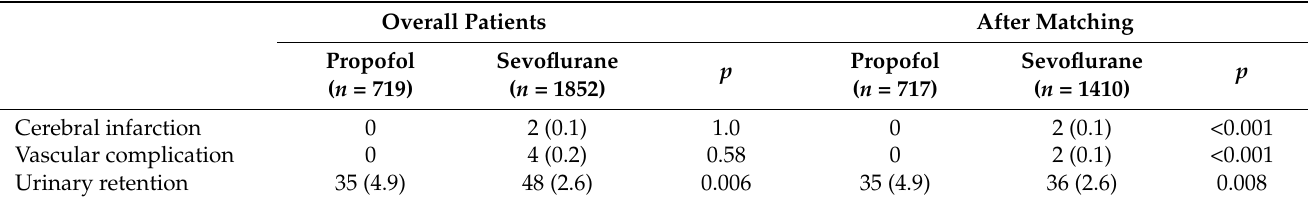
Table 2. Cont. Overall Patients